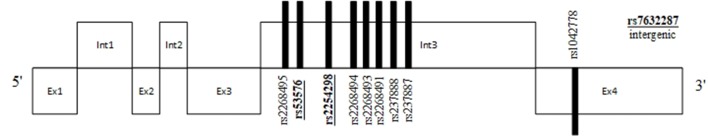
Position of commonly studied single-nucleotide polymorphisms (SNPs) and their relation to exons and introns of the oxytocin receptor (OXTR) gene. SNPs in bold and underlined were found to be associated with social cognition deficits.